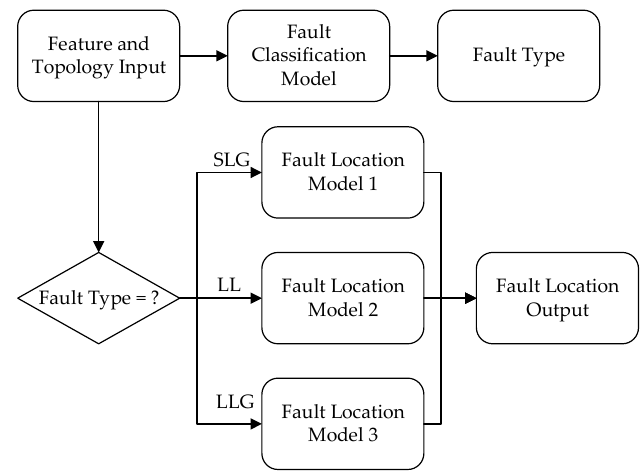
Figure 2. Process for fault classification and location.